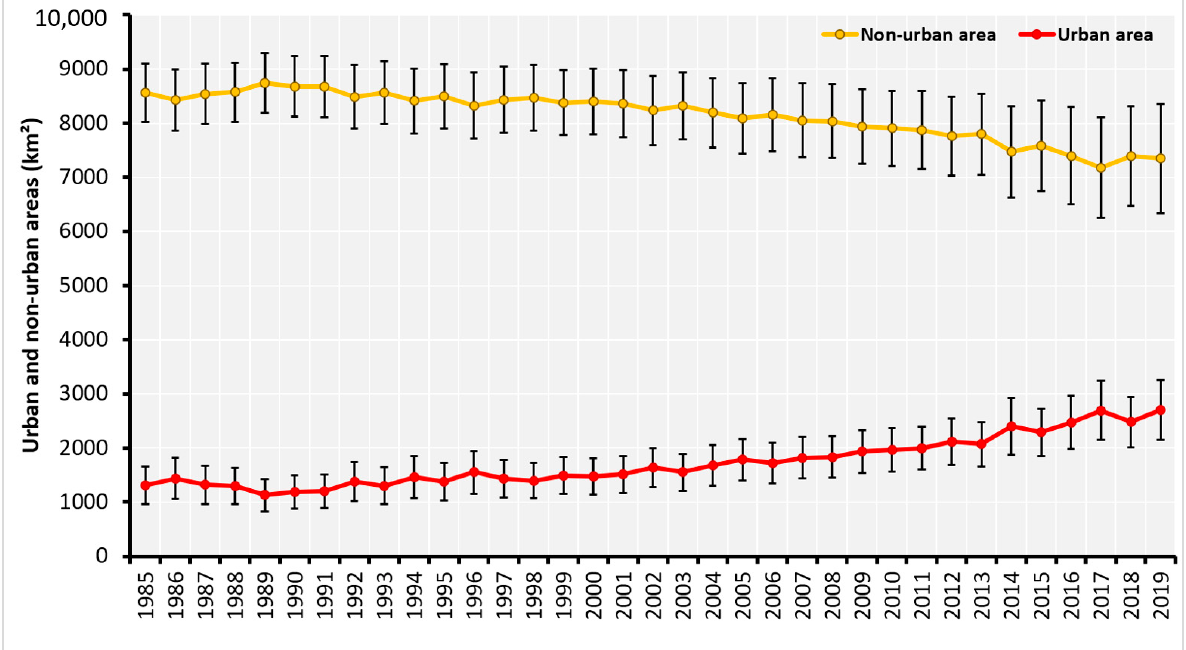
Figure 7. Unbiased urban and non-urban area estimates from 1985 to 2019 (95% confidence intervals are represented by the error bars).